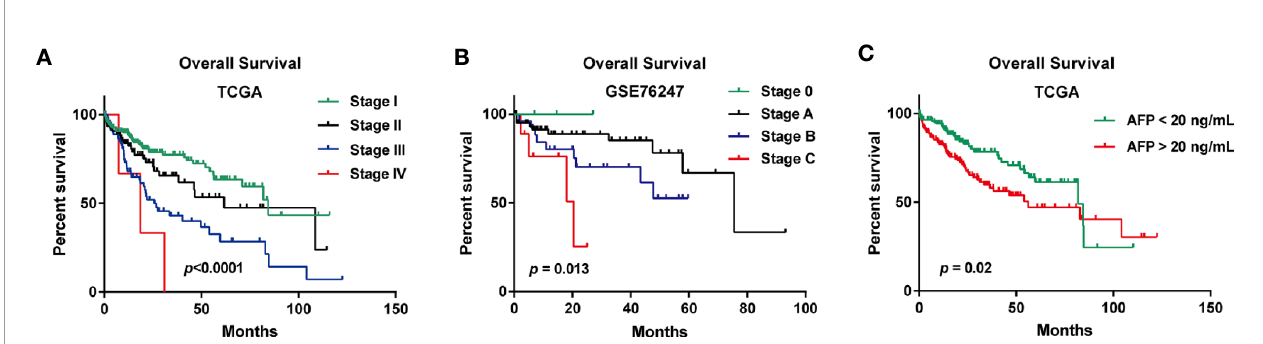
FIGURE 2 | Survival analysis of clinical characteristics of the patients included in OSlihc. (A) Pathologic stage, (B) BCLC stage, (C) Serum AFP